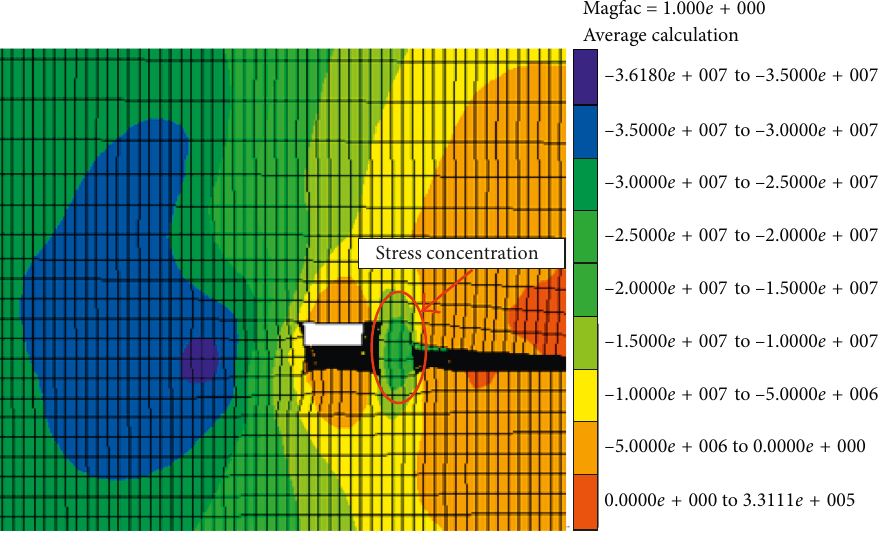
Figure 4: The vertical stress distribution characteristic of the roadway surrounding